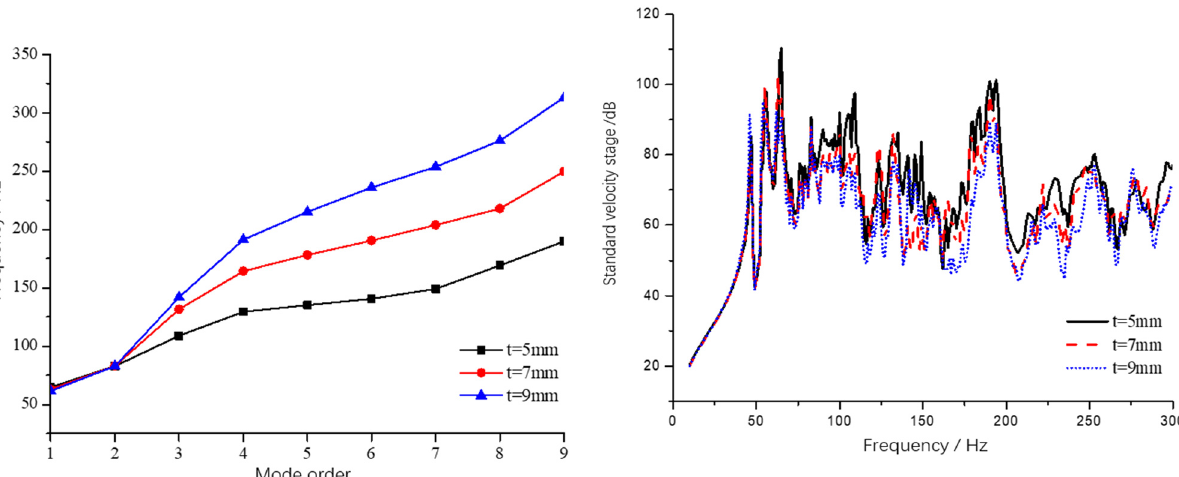
Figure 15: Spectrum of mean square vibration velocity of C cabin deck.